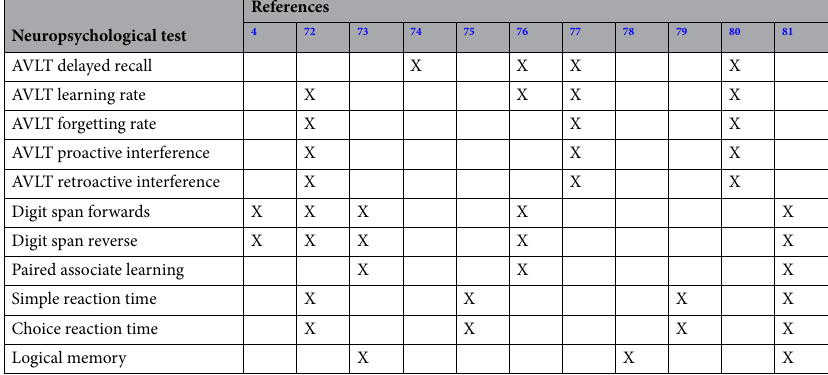
Outcomes n Studies n Individuals